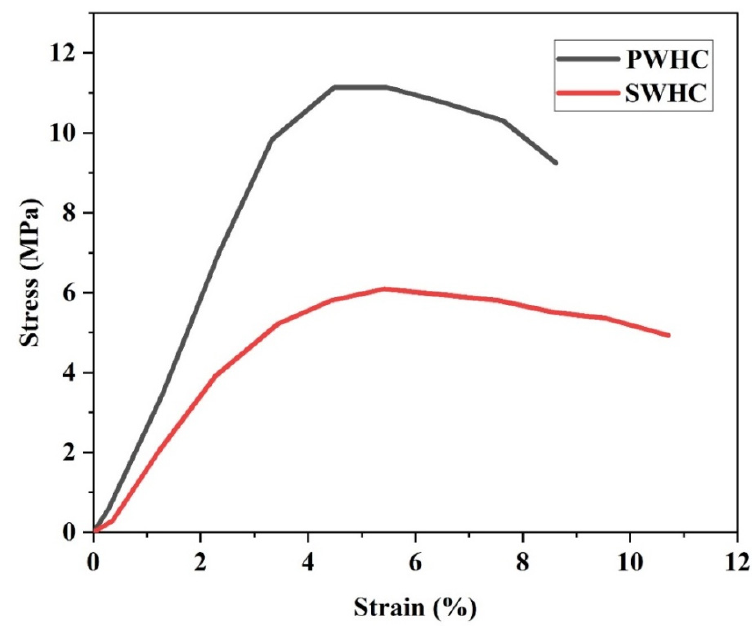
Figure 2. Stress–strain curve of the SWHC and PWHC. Table 3. Tensile and tear properties of the SWHC and